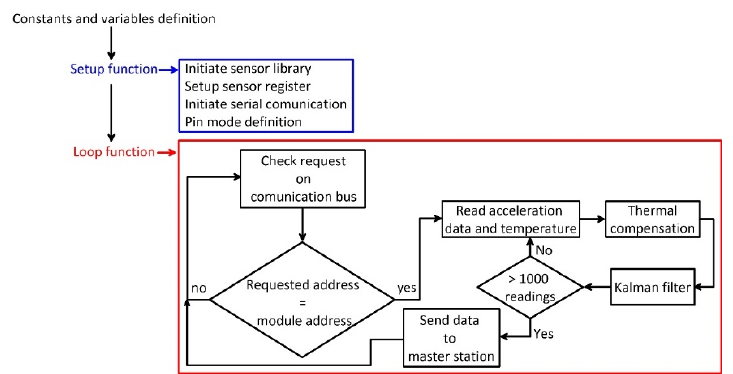
Figure 6. Flow chart showing the logic of the code of each measuring unit. In this case, due to the logic of data reading and acquisition, the loop is divided in two parts, the first for receiving the measure request by the master station and the second for reading sensors and sending data to the master station.